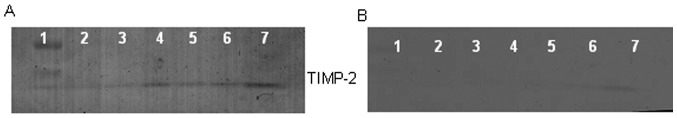

Effect of NM on osteosarcoma MNNG-HOS, osteosarcoma U-2OS and rhabdomyosarcoma RD TIMP-2 expression. Reverse zymograms of (A) MNNG-HOS, (B) U-2OS and (C) RD TIMP-2 expression. Legend: 1, markers; 2, control; 3–7, NM 50, 100, 250, 500 and 1,000

μ

g/ml, respectively. Densitometric analyses of (D) MNNG-HOS, (E) U-2OS and (F) RD TIMP-2 expression.